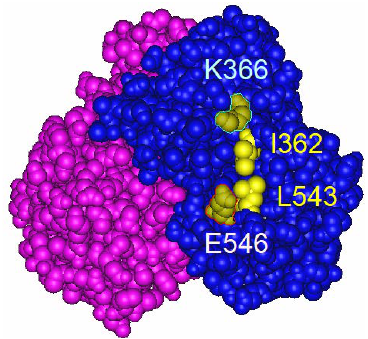
Figure 2. Crystallographic structure of E2-bound LBD dimer of ER α . The diagram was generated from the human ER α LBD with 17 β -E2 (Protein Data Bank ID: 1ERE). The dimer form of pink and blue ER α LBD molecules is shown. The residues suggest the position corresponding to the I362, K366, L543 and E546 of mouse ER α . I362 and L543 are hydrophobic amino acids (yellow), K366 is a basic amino acid acid (blue) E546 is an acidic amino acid (red). (blue) E546 is an acidic amino acid